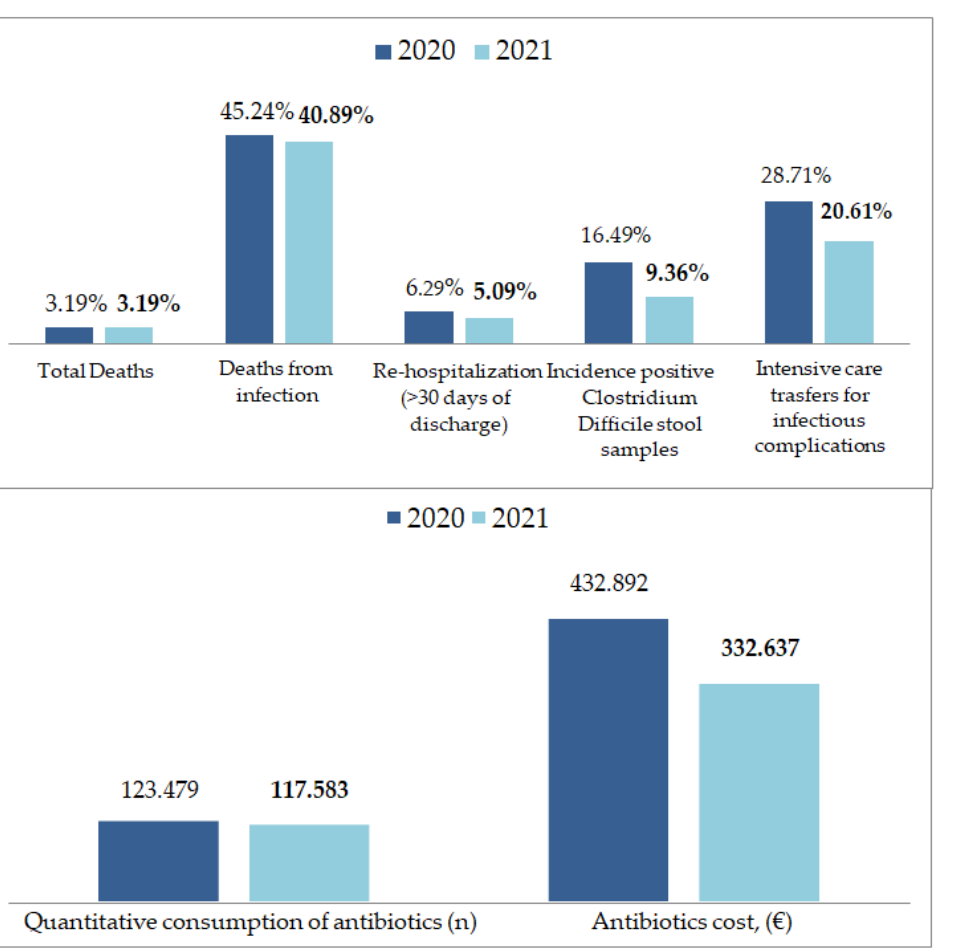
Figure 1. The main AMS program outcome measures and results.